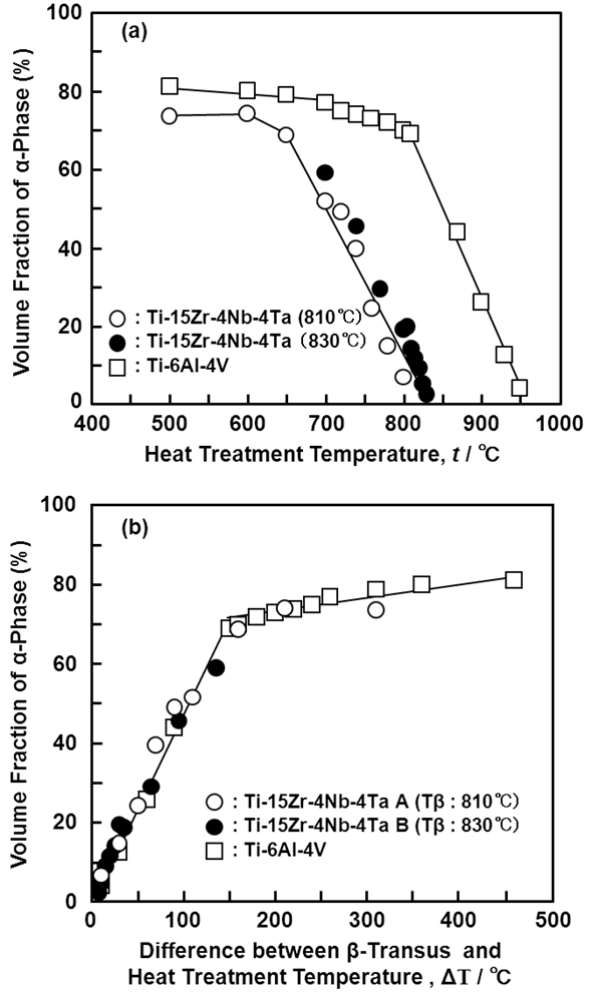
Figure 6. ( a ) in volume fraction of α -phase as a function of heat treatment temperature; and ( b ) difference ( Δ T) between T β and heat treatment